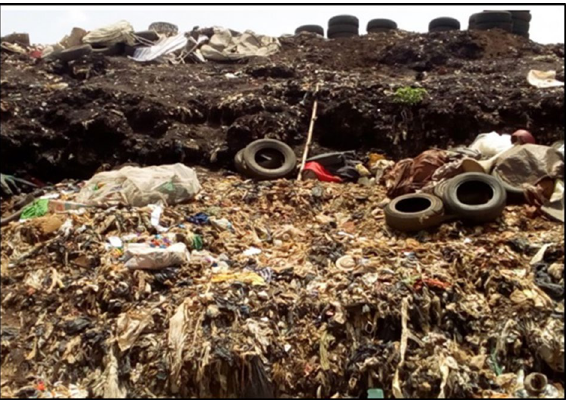
Figure 1. Photo showing the compositions of the refuse on the surface of the